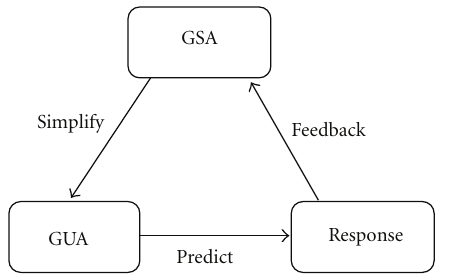
Figure 1: Application of GUA and GSA to structural